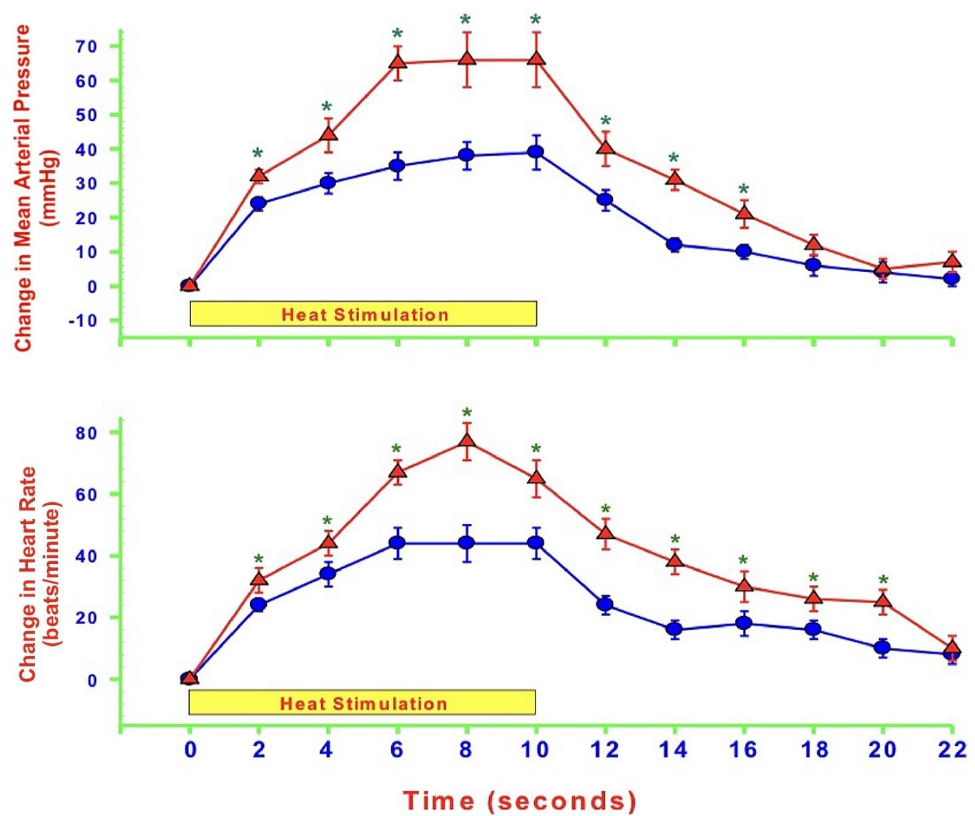
Figure 4. Average time-course changes in mean arterial pressure (MAP: upper panel) and heart rate (HR: lower panel) during 10 s hind paw heat-induced thermal stimuli 120 min after bilateral insertion of microdialysis probes into the dorsolateral periaqueductal gray matter (control: blue circles) and 30 min after microdialysis of L-N(5)-(1-iminoethyl)ornithine (L-NIO: 10 µM: red triangles; an endothelial nitric oxide synthase antagonist) into the same area of anesthetized rats. The Y-axes are changes in MAP or HR, and the yellow boxes represent the 10 s time of stimulation. Values represent means ± SEM ( n = 8) and * p < 0.05 represents value versus control.